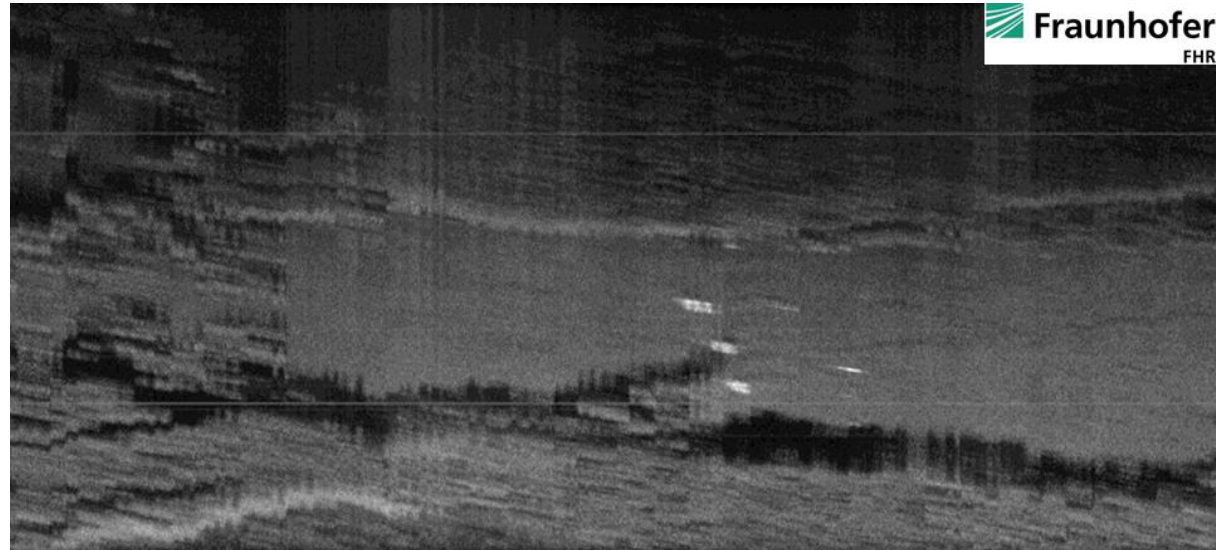
Fig. 13 Screenshot of the real time projection of the received reflected energy over time